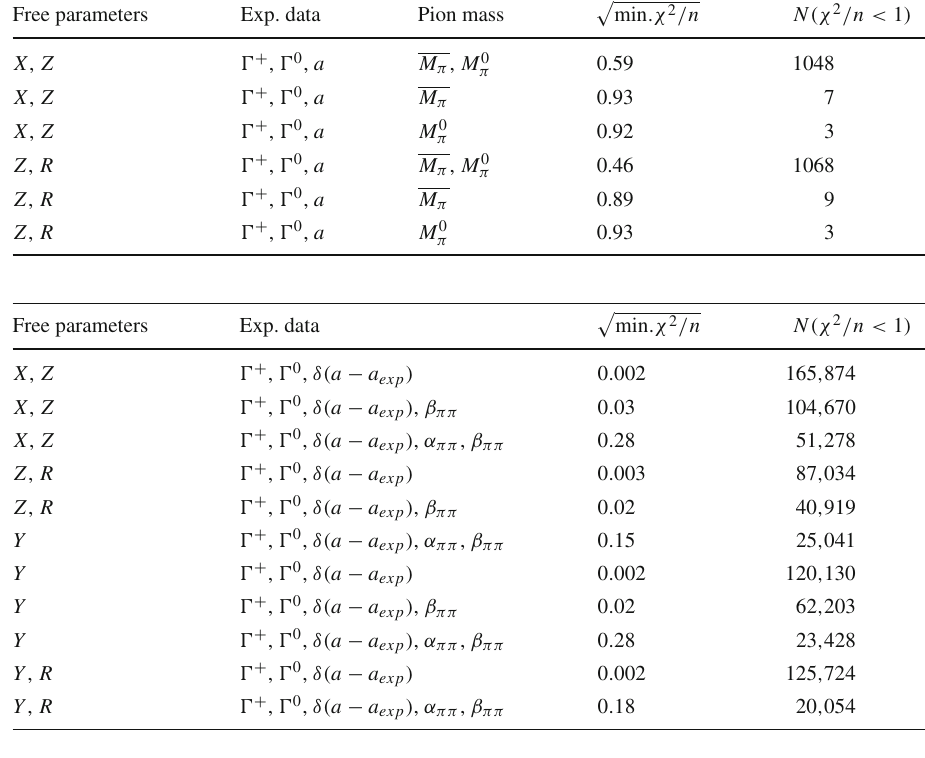
Table 5 χ 2 -based comparison